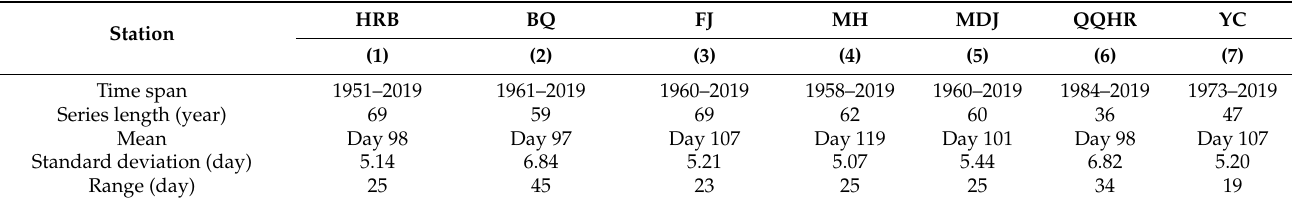
Table 1. Characteristic of break-up date series at each